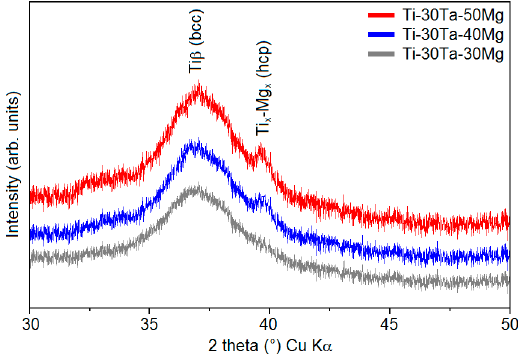
Figure 2. XRD spectra of the Ti-30Ta-(30-50)Mg alloys after 40 h of MA process.